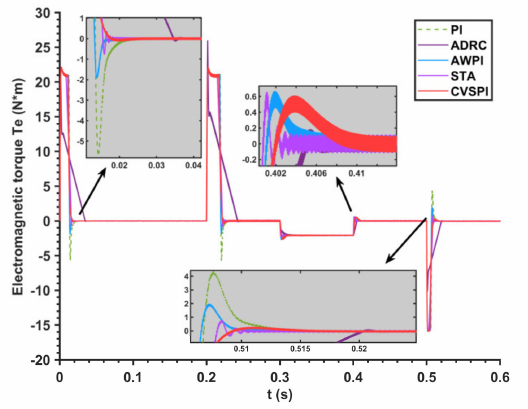
Figure 12. Torque response comparison